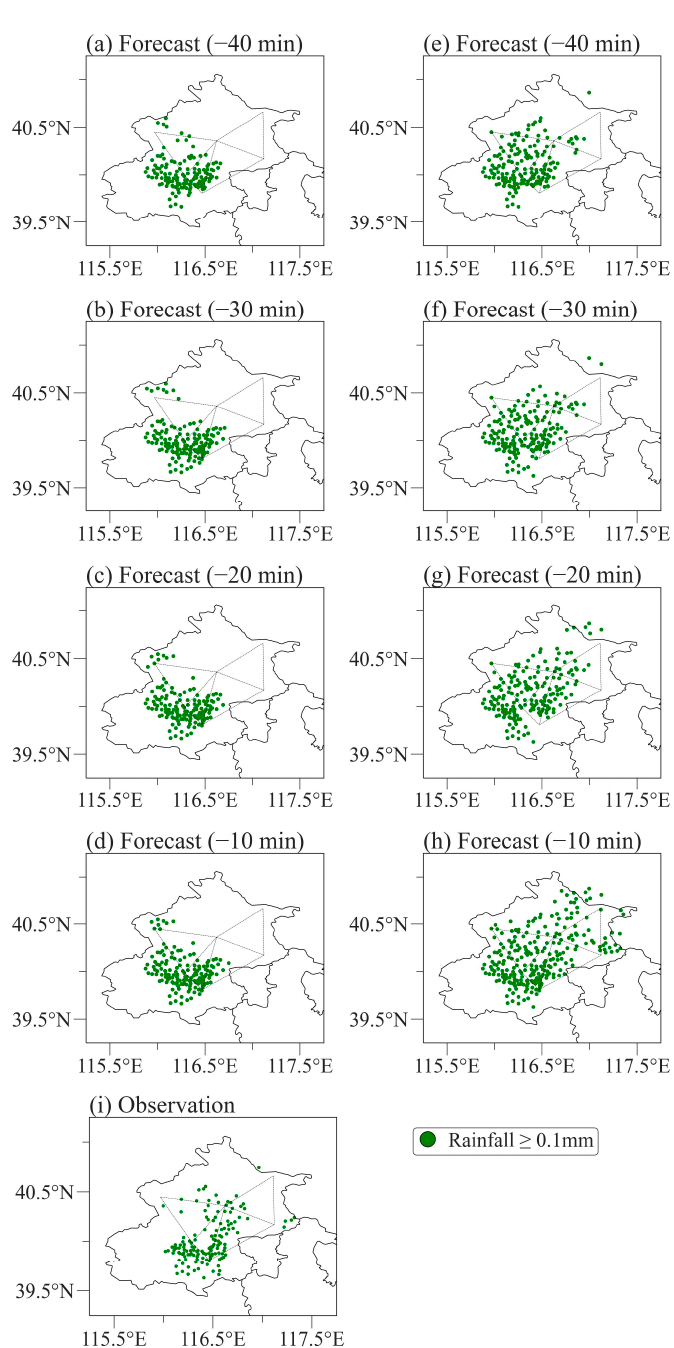
Figure 10. The forecast output results of the random forest model within 30 min before the rainfall initiated at 23:20 BJT on 16 July 2018, where panels ( a – d ) are based on the features of divergence, vorticity, and vertical velocity from the RWP measurements (the binary RWP model) and panels ( e – h ) are from the ERA-5 reanalysis data (the binary ERA-5 model). The panels ( i ) is the rainfall observation record at 23:20 BJT. Table 4. Summary of the performance metrics of the RF model used to carry out the rainfall/non- rainfall forecast within 30 min before the rainfall onset at 23:20 BJT on 16 July 2018.